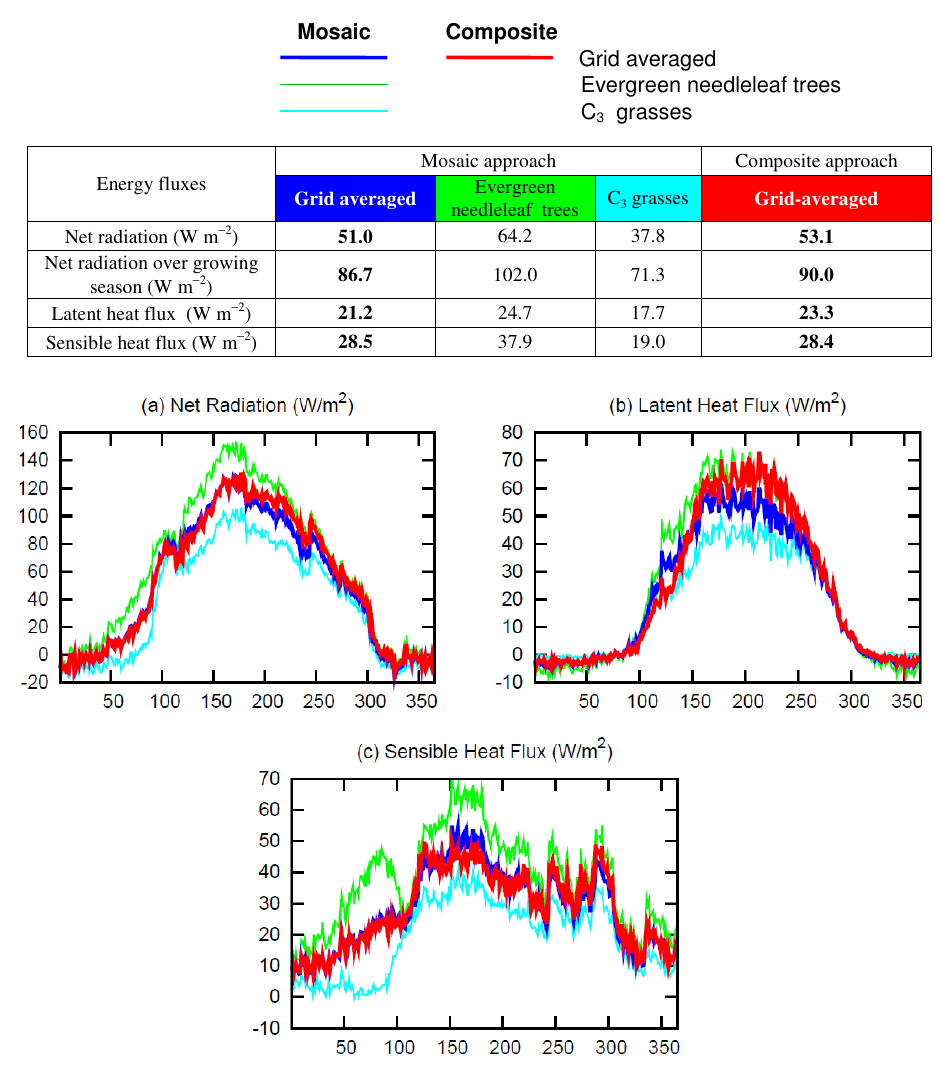
Fig. 2. Simulated daily average values of (a) net radiation, (b) latent heat flux and (c) sensible heat flux for the Manitoba location. The blue and the red lines represent grid-averaged values for the mosaic and composite approaches, respectively. The green and cyan lines represent values for the evergreen needleleaf tree and C 3 grass tiles in the mosaic approach, respectively. There are no PFT specific energy fluxes in the composite approach. The table at the top summarizes the average annual values of the fluxes when using the two approaches.